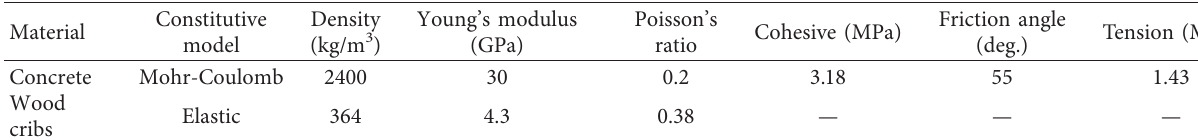
Table 7: Parameters for the concrete and the wood cribs.